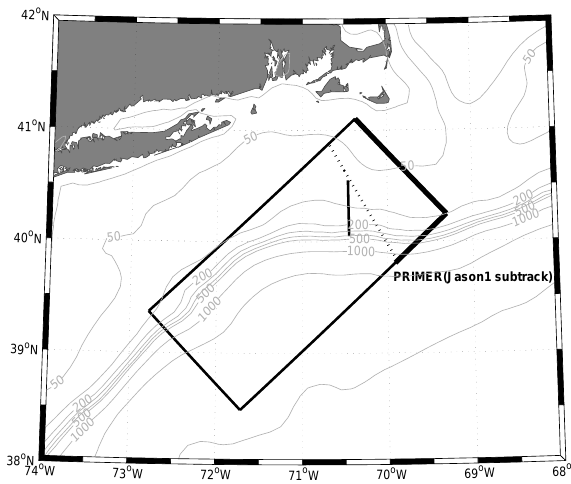
Fig. 1. The shelfbreak model domain (box) and the location of Nan- Figure 1. The shelfbreak model domain (box) and the location of Nantucket transect 768 tucket transect discussed in the following sections (solid line). Also discussed in the following sections (solid line). Also shown is a satellite (Jason1) 769 shown is a satellite (Jason1) sub-track (dotted line). The thick line sub-track (dotted line). The thick line along the northeastern boundary defines the 770 along the northeastern boundary defines the location of the upstream location of the upstream nutrient input calculation. Local isobaths are also shown in 771 light gray. 772 nutrient input calculation. Local isobaths are also shown in light